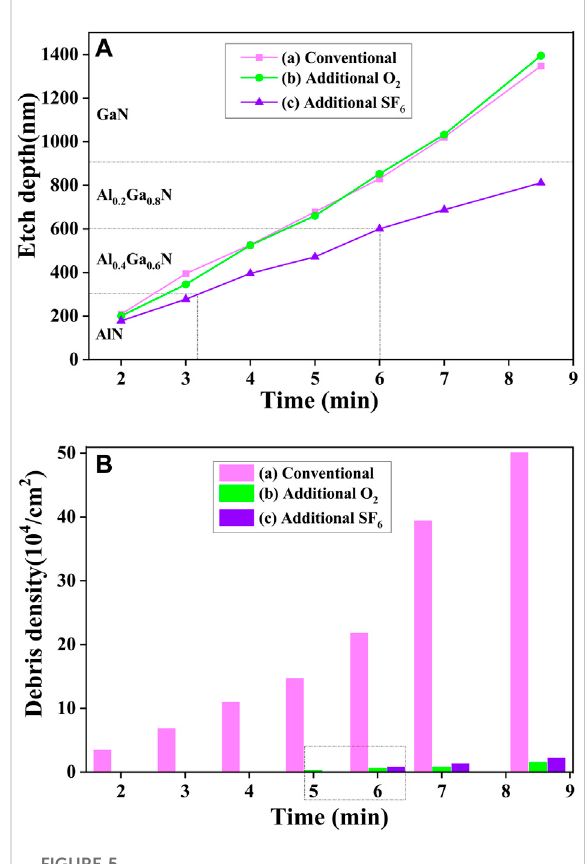
FIGURE 5 The (A) Etch depth and (B) Debris density of the etched N-polar Al x Ga 1-x N layers versus time with Conventional (a), Additional O 2 (b) and Additional SF 6 (c) etching in the BCl 3 and Cl 2 gases during the etching